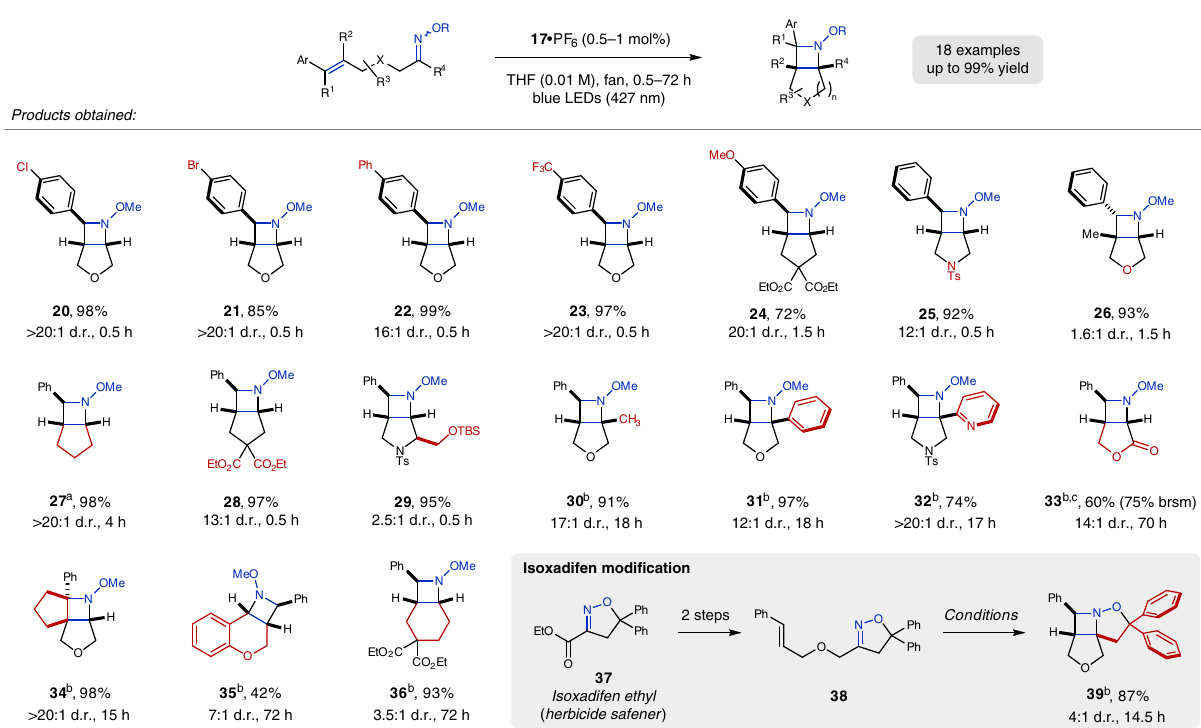
Fig. 3 Scope of the [2 + 2] cycloaddition reaction. Reactions were performed with 0.25 mmol substrate (mixture E / Z oxime isomers) and 0.5 – 1.0 mol% 17 (cid:129) PF 6 in THF (0.01 M) at ambient temperature (fan cooling) under blue LED irradiation (427 nm) unless noted; diastereomeric ratios (d.r.) were determined by 1 H NMR from the crude reaction mixture; isolated yields refer to the mixture of diastereomers (major diastereomer is given); a on 500 mg scale; b under N 2 atmosphere; c run at 82